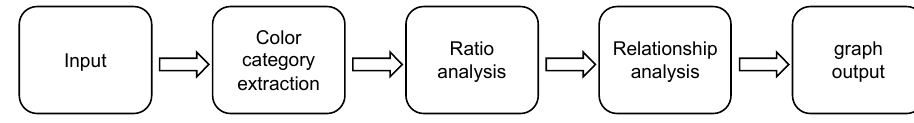
Figure 3. Flow chart of our proposed color graph extraction method.